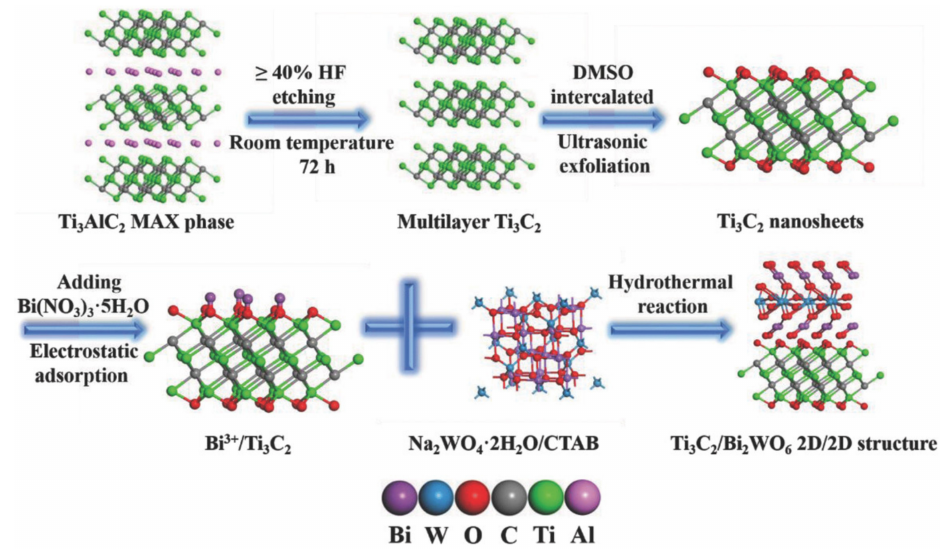
Figure 4. The synthetic process of the novel 2D/2D Ti 3 C 2 /Bi 2 WO 6 heterostructure. Reprinted with permission from Ref. [75]. 2018, John Wiley and